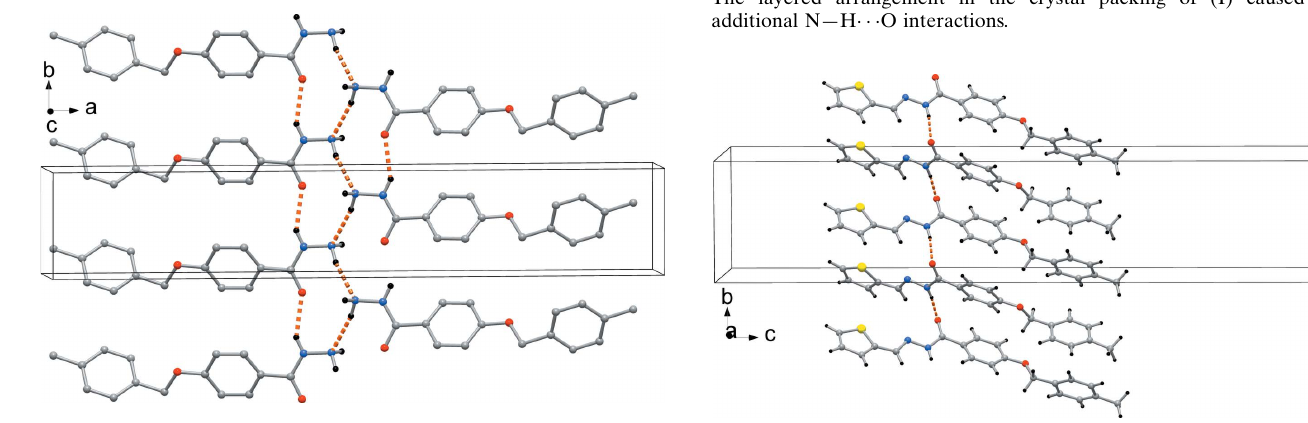
Figure 4 The rows built by N—H (cid:2)(cid:2)(cid:2) N and N—H (cid:2)(cid:2)(cid:2) O interactions (orange dashed lines) in the crystal structure of (I).